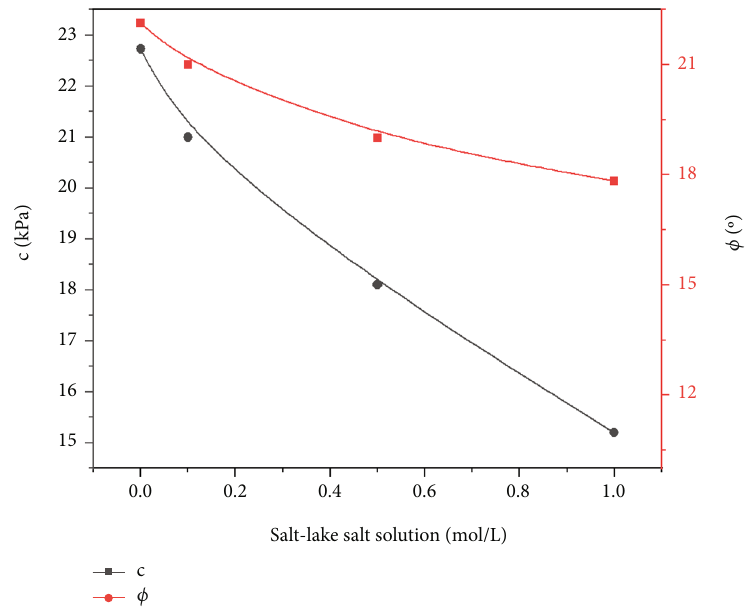
Figure 3: The relationship between c , φ , and SLS solution